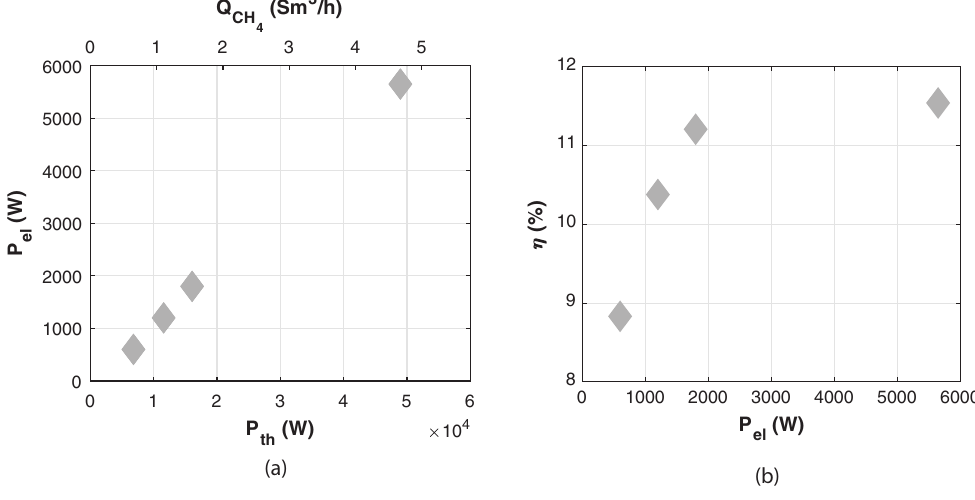
Figure 7. Power levels ( a ) and nominal efficiencies ( b ) of FPSEs. The FPSEs performance is not significantly affected by the ambient temperature. The allowed operating temperature is between − 25 and 50 ◦ C, whereas the minimum